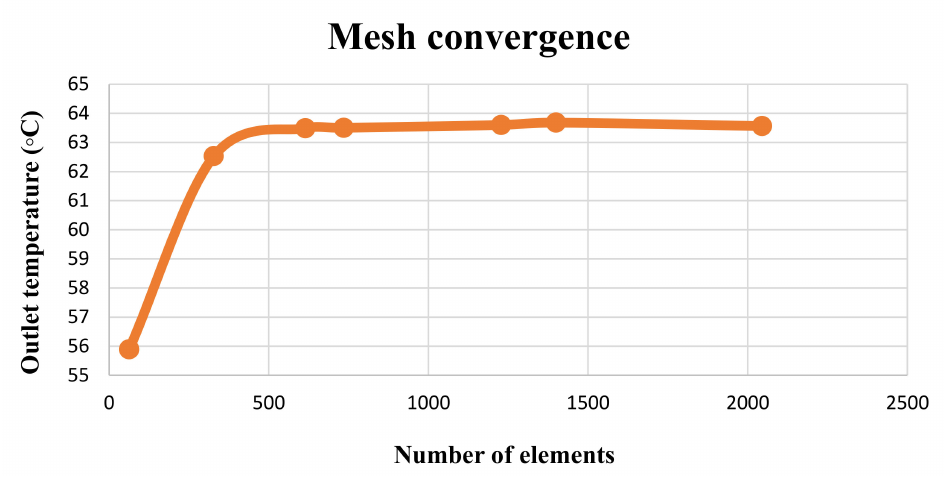
Figure 2. Mesh convergence study by varying elements’ size from 15 mm to 5 mm.